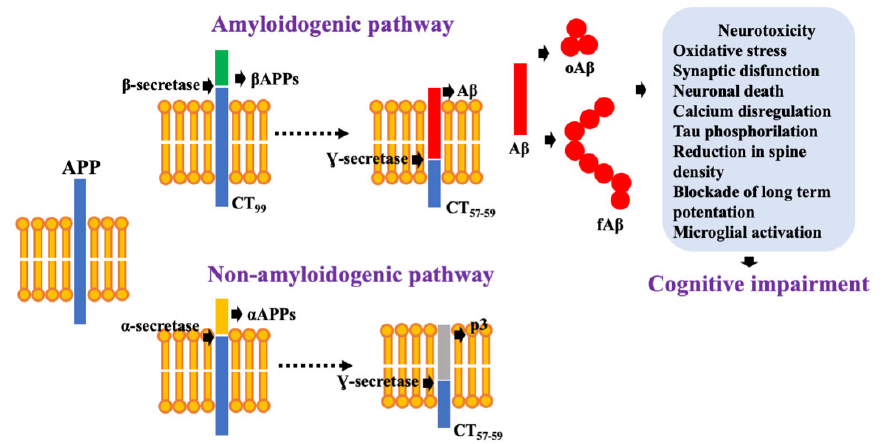
Figure 1. A β production following the amyloidogenic pathway. Once A β is released it tends to establish interaction with other monomers to form oligomeric (oA β ) and fibrillar species (fA β ), which are highly